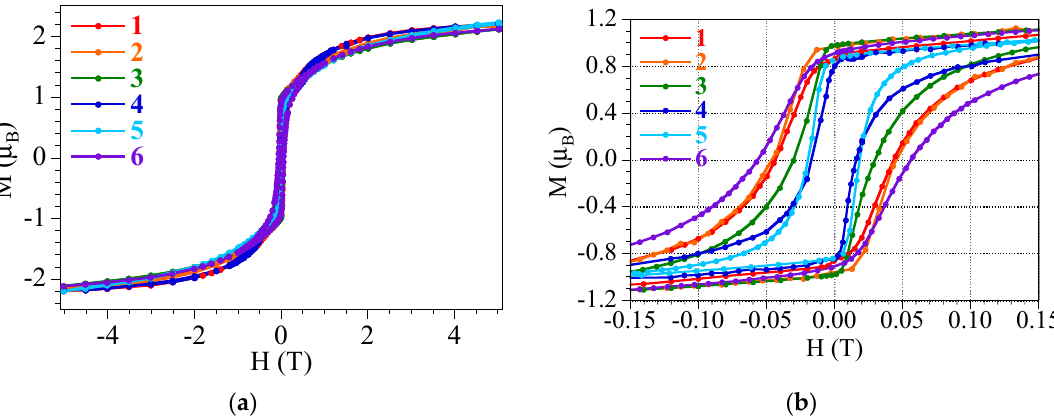
Figure 7 . ( a ) Isothermal magnetization cycles at 2 K for compounds 1 – 6 . ( b ) The low field region. Table 5. Magnetic properties of compounds 1 – 6 .